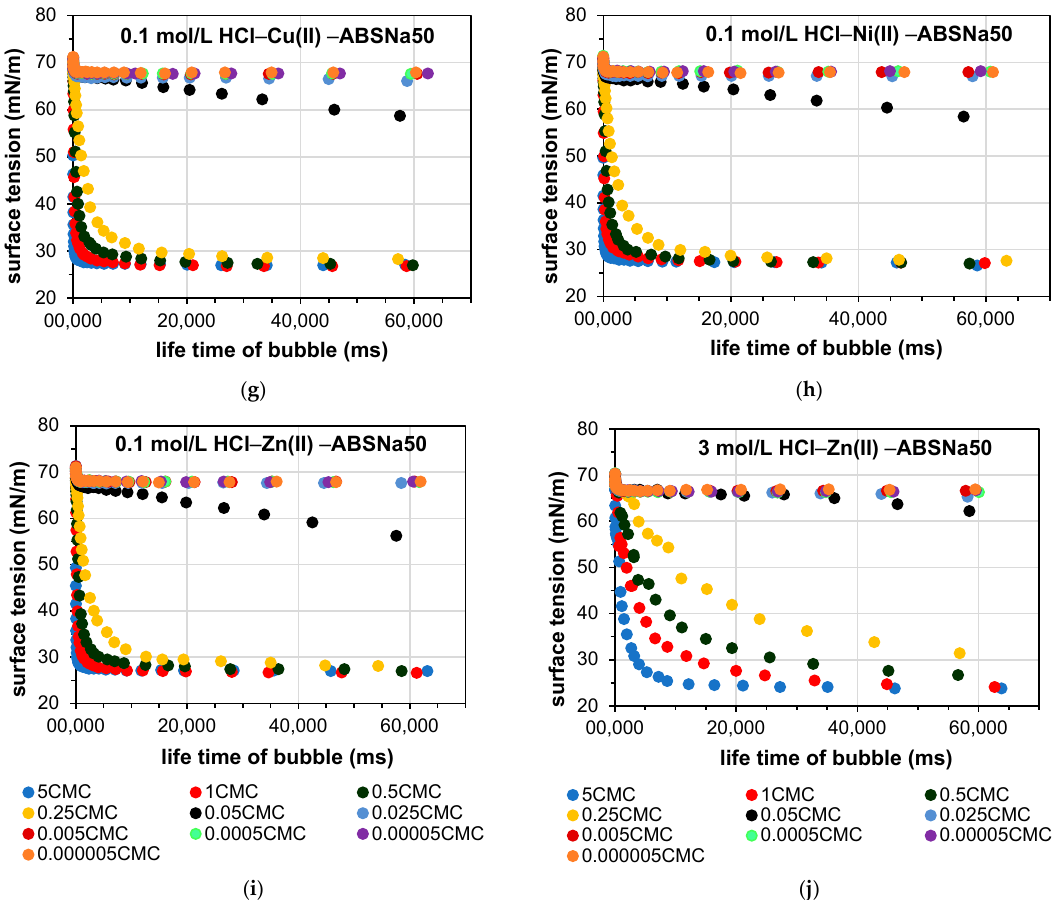
Figure 7. Plot of DST versus time for different anionic surfactant concentrations (water-ABS ( a ), water-ABSNa50 ( b ), 3 mol/L HCl-ABS ( c ), 3 mol/L HCl-ABSNa50 ( d ), 0.1 mol/L HCl-Co(II)-ABS ( e ), 0.1 mol/L HCl-Co(II)-ABSNa50 ( f ), 0.1 mol/L HCl-Cu(II)-ABSNa50 ( g ), 0.1 mol/L HCl-Ni(II)-ABSNa50 ( h ), 0.1 mol/L HCl-Zn(II)-ABSNa50 ( i ), 3 mol/L HCl-Zn(II)-ABSNa50 ( j )) measured by the maximum bubble pressure methods—the selected examples (5 CMC ABS = 0.0063 mol/L, 5 CMC ABSNa50 = 0.0073 mol/L).